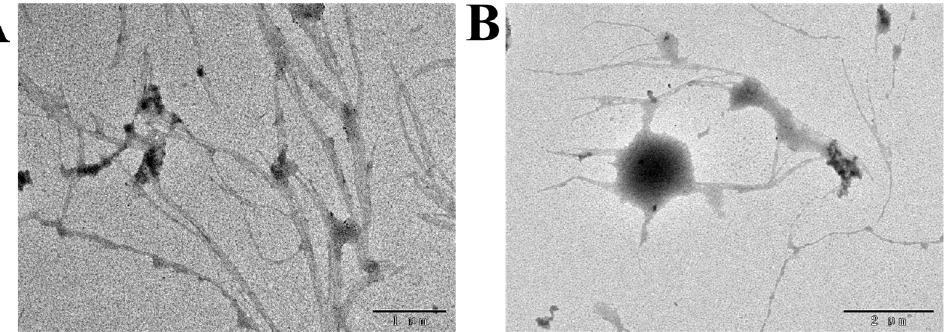
Figure 7. Transmission electron microscopic images (( A ): 2000×, ( B ): 4000×) of the EPS produced by Lpb. plantarum NMGL2.